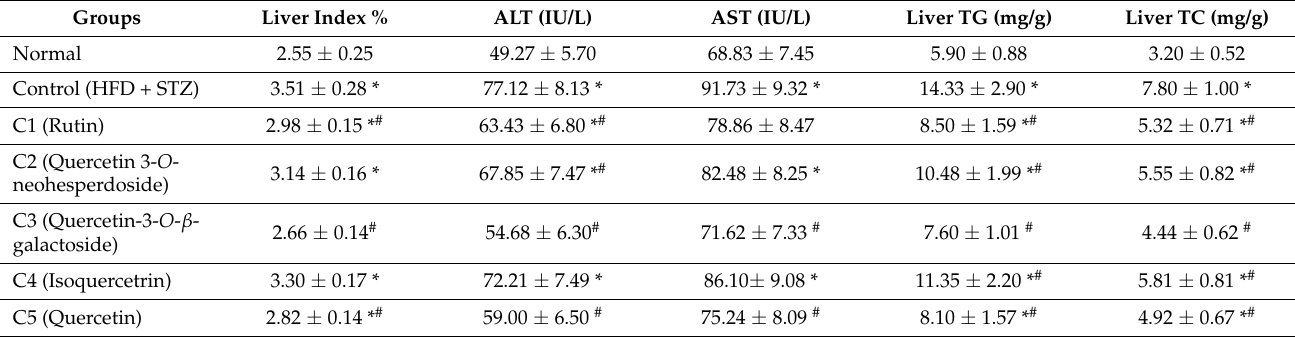
Table 4. The effect of the isolated compounds on the liver index, liver enzymes, and liver content of lipids in the experimental rats.